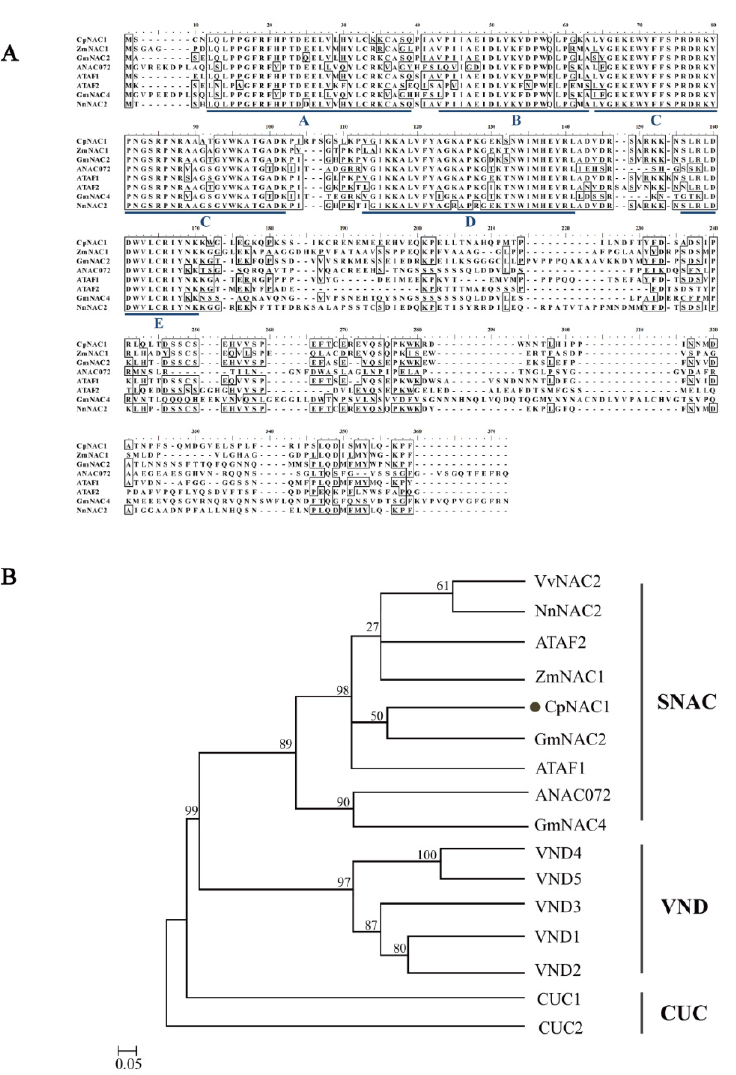
Figure 1. Sequence analysis of CpNAC1. ( A ) Multiple sequence alignment of CpNAC1 and its orthologs from other plants. The N-termini of CpNAC1 conserved domains in five subdomains (A–E) are marked with blue lines below the sequence alignment. ( B ) Phylogenetic tree of CpNAC1 and NAC proteins. The phylogenetic tree was constructed using MEGA 7.0 software and the neighbor-joining (NJ) method (1000 bootstraps). CpNAC1 is indicated by a dot. Zea mays ZmNAC1 (ABY67929.1), Glycine max GmNAC2 (NP_001240958), GmNAC4 (NP_001238424), ANAC072 (OAO97067), Arabidop- sis thaliana ATAF1 (CAA52771), ATAF2 (AAM65967), VND1 (OAP07379.1), VND2 (OAO96839.1), VND3 (OAO91397.1), VND4 (OAP17154.1), VND5 (OAP18936.1), CUC1 (ACB31158.1), CUC2 (ACB31182.1), Nelumbo nucifera NnNAC2 (XP_010268987), Chimonanthus praecox CpNAC1, and Vitis vinifera VvNAC2